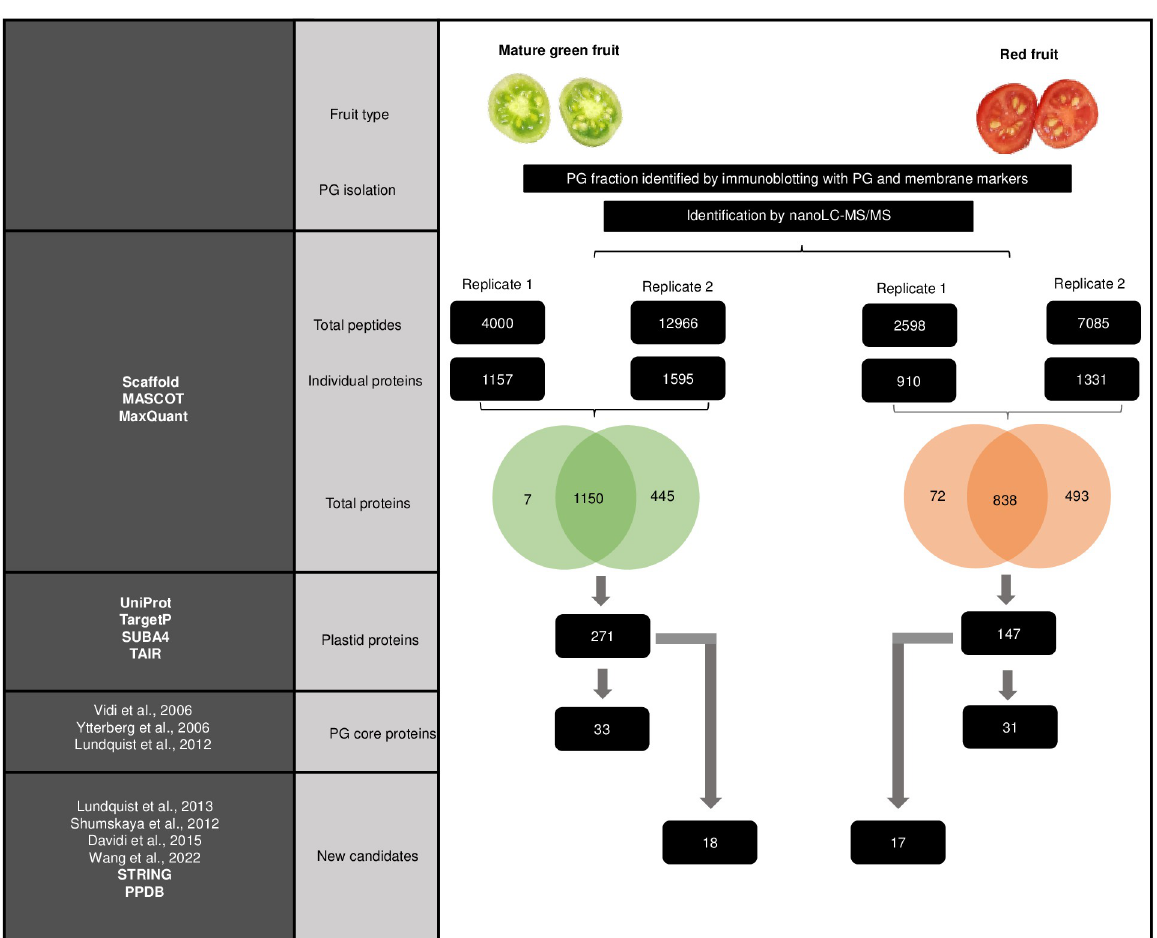
Fig 2. Experimental design used for tomato fruit PG proteome analysis. PGs from mature green and red fruit were isolated separately by sucrose gradient flotation. The two independent replicate PG fractions from mature green and red fruit were analyzed by nano-liquid chromatography (nanoLC)-electrospray ionization (ESI)-tandem mass spectrometry (MS / MS) for peptide identification. All identified peptides (Total Peptides) were further processed by Scaffold, MASCOT, and MaxQuant software to obtain corresponding individual proteins (Individual proteins). The number of individual proteins collected after merging two independent replicates (Total proteins). The Total proteins were filtered using the Uniport, TargetP, SUBA4, and TAIR databases to identify plastid protein (Plastid protein). Plastid proteins were filtered using known chloroplast and chromoplast proteome based on the existing literatures resulting in PG core proteins (PG core proteins). The new PG protein candidates (New candidates) were identified by exclusion of curated stromal, thylakoid and envelope proteins from plastid proteins (Plastid proteins) using PPDB and STRING databases as well as subcellular localization studies in the